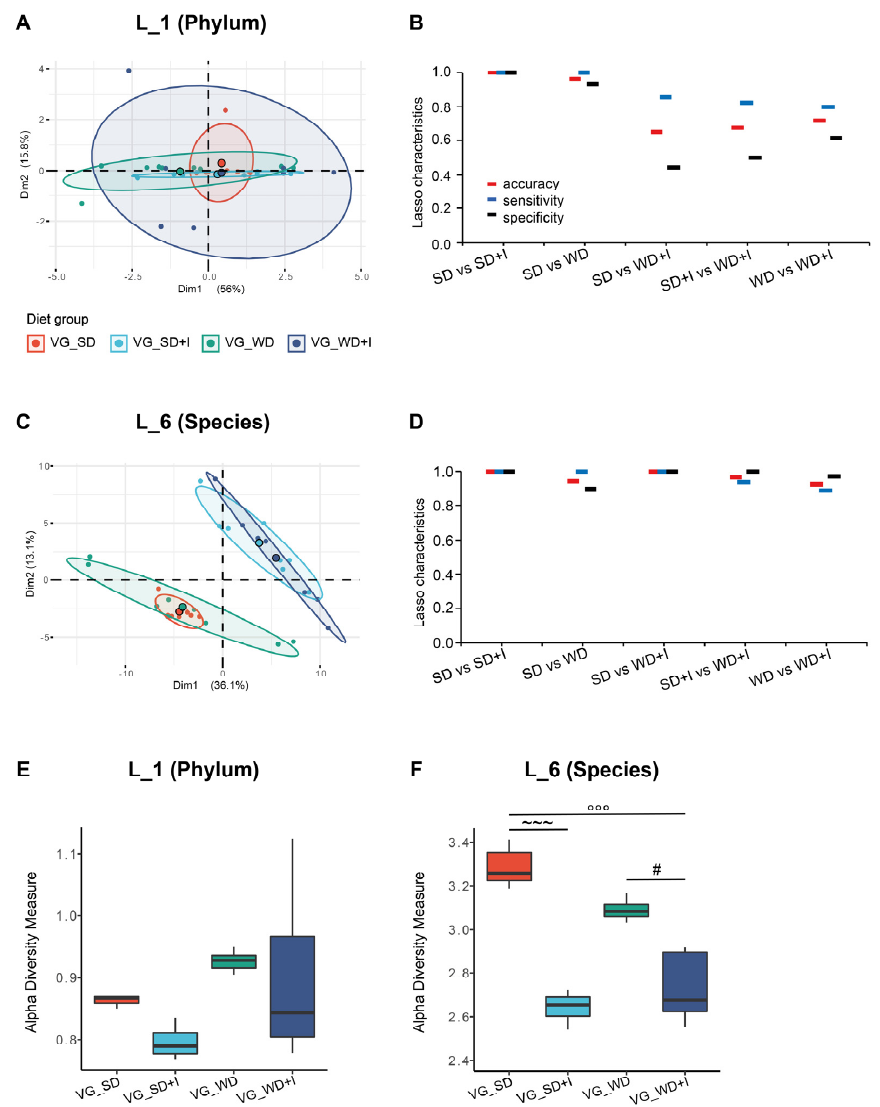
Figure 3. Cecum microbiota composition in humanized mice. ( A , C ): The 2D PCA scores plot. The explained variance of each component is included in the axis labels. The large points represent the centroids of each group. ( B , D ): Held-out characteristics of Lasso logistic regression model. ( E , F ): Alpha diversity of cecum microbiota assessed as Shannon index. ~~~ p ˂ 0.001 VG_SD + I vs VG_SD; °°° p ˂ 0.001 VG_WD + I vs VG_SD; # p ˂ 0.05, p VG_WD + I vs VG_WD. Data are shown as box plots (1st and 3rd quartile, median) with whiskers (min, max).